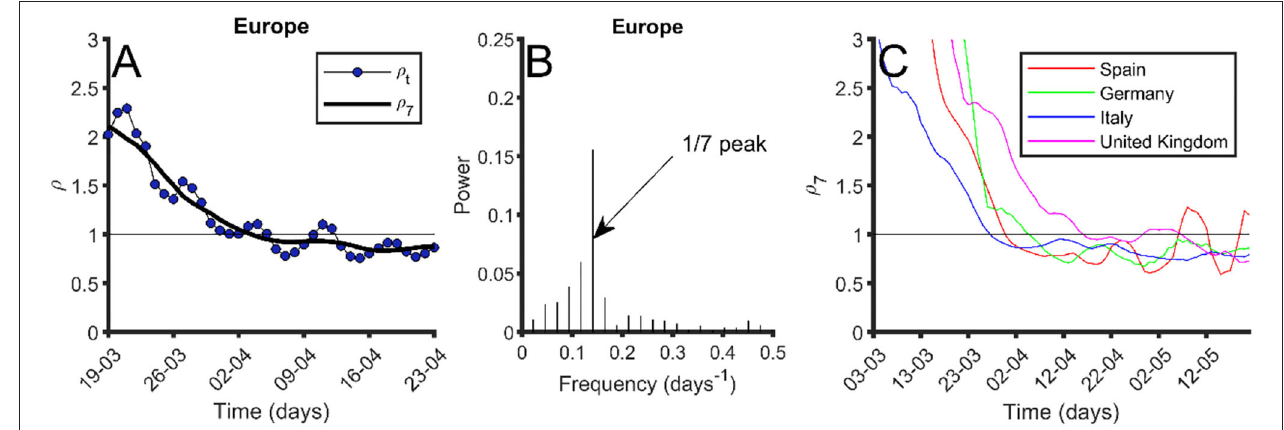
FIGURE 1 | Index ρ t evolution and periodicity. (A) In blue dots, evolution of ρ t in Europe; black thick line, 7-day moving average of ρ t ( ρ 7 ). (B) Fourier transform of ρ t . The peak at frequency 1/7 days − 1 is pointed out. (C) Seven-day moving average of ρ t ( ρ 7 ) for different European countries: Spain (red), Germany (green), Italy (blue), and United Kingdom (purple). Data were obtained from the European Center for Disease Prevention and Control (24) on May 25,